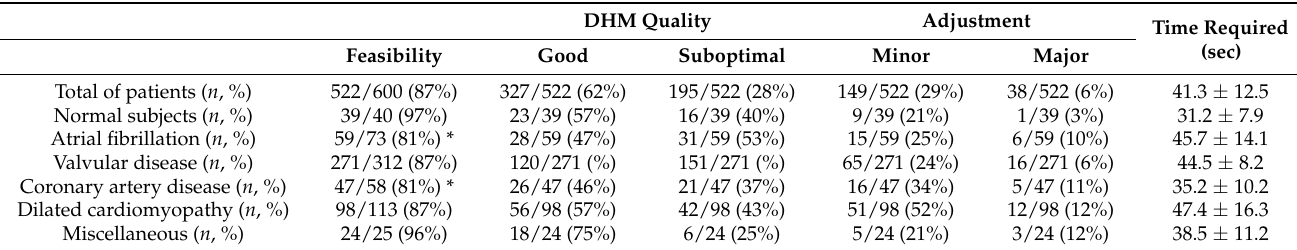
Table 2. Feasibility of DHM, image quality, need for adjustments and time required for measurements in global population and in each subgroup. DHM: dynamic heart model. * p < 0.05 vs. normal subject.